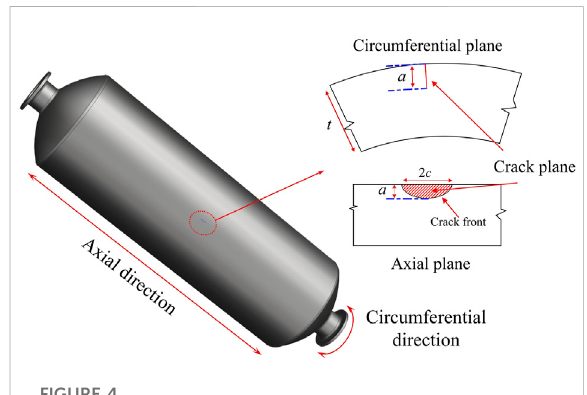
FIGURE 4 Semi-elliptical crack on the external surface of pressure vessels.